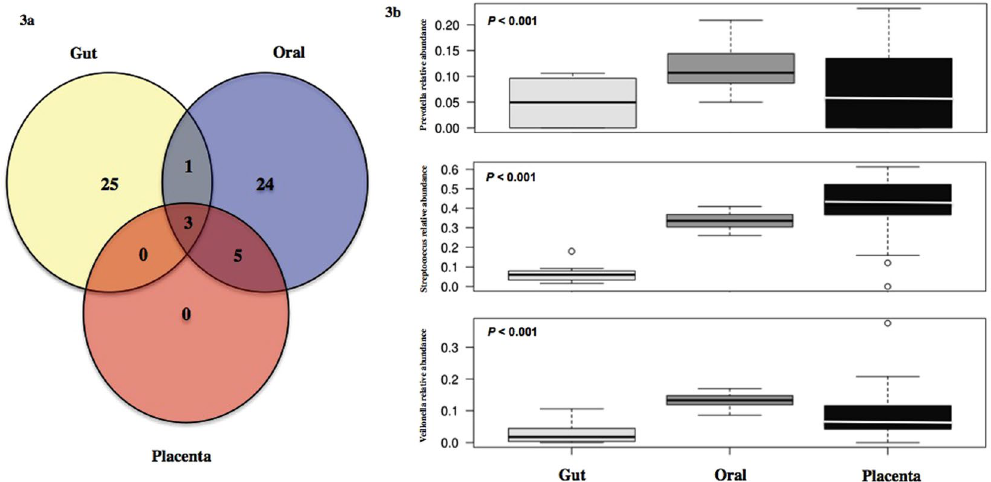
Figure 3. Core shared and distinct genera between the maternal gut, oral and placental microbiome. ( a ) Core microbiomes consisting of genera detected in > 50% of samples from each body site were obtained and plotted in a Venn diagram. Three shared genera: Prevotella, Streptococcus and Veillonella were present in all samples. No unique core genera was detected in the placenta, all were shared between the two maternal microbiomes. Detailed genera among the three body sites are listed in Supplementary Table 3. ( b ) Relative abundances of genera: Prevotella, Streptococcus and Veillonella in all three maternal compartments. Relative abundances among body sites and genera were significantly different (p <